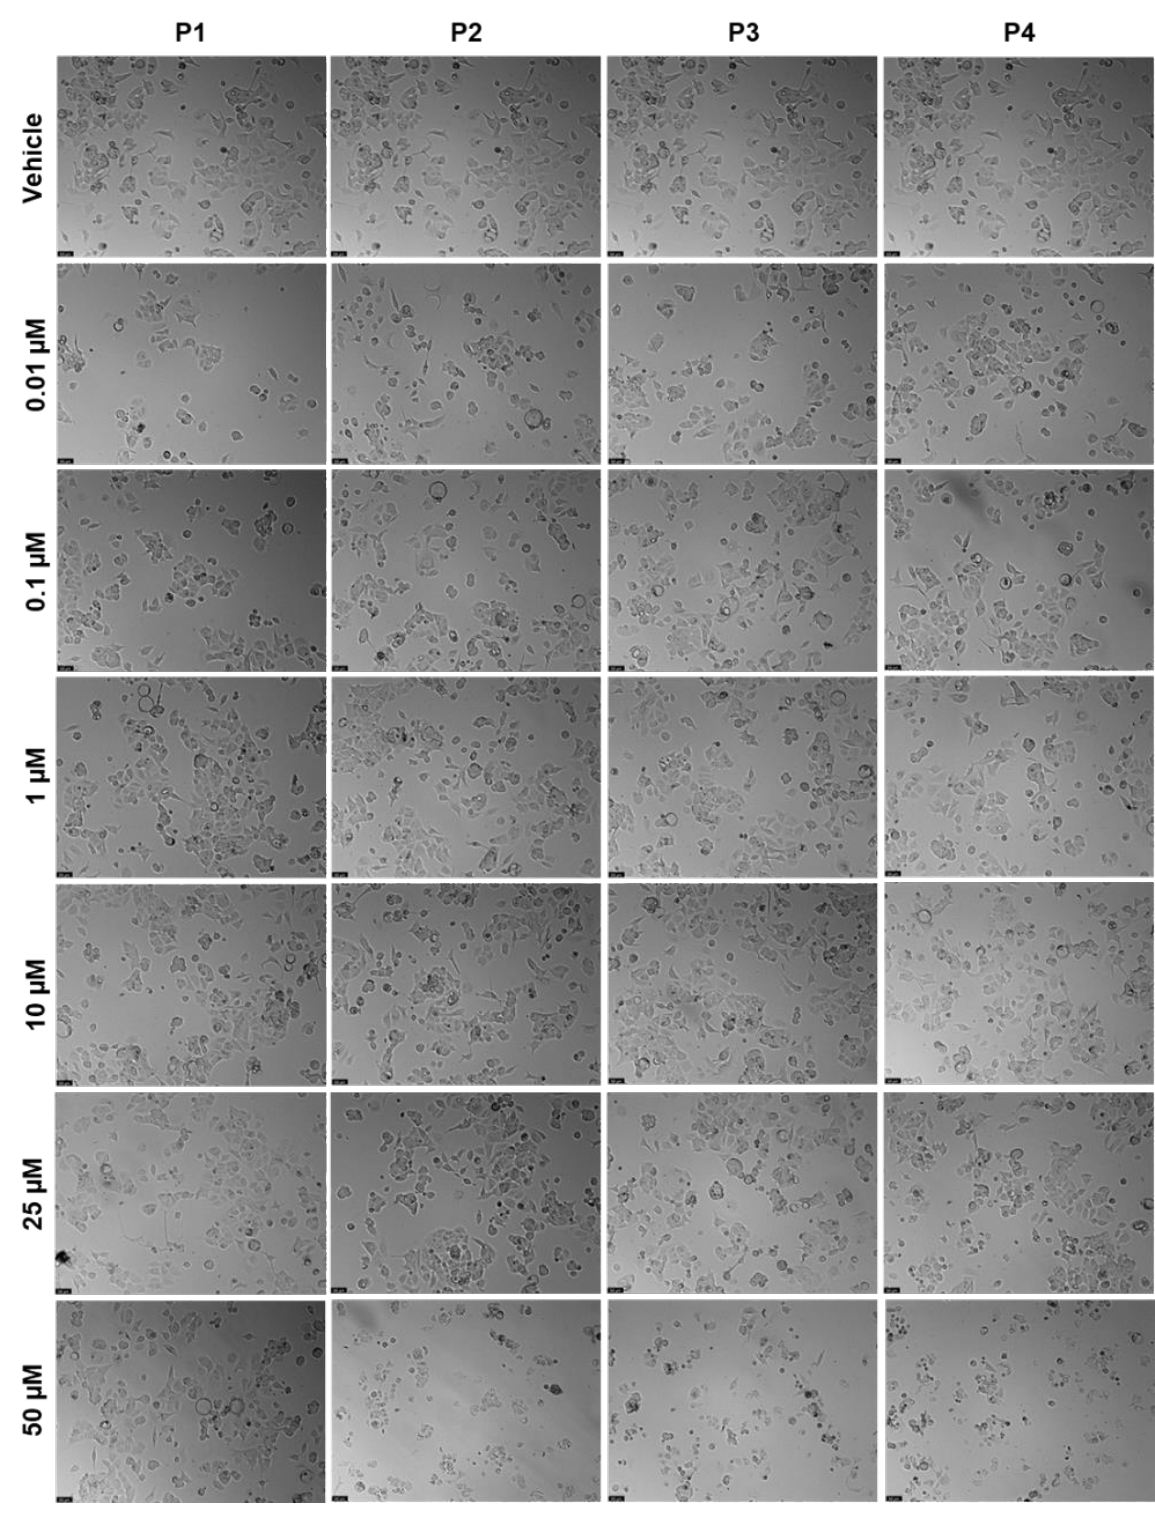
Figure 10. Morphological evaluation of MCF-7 after exposure to increasing concentrations of P1 – P4 (0.01 – 100 μM ) for 48 h. Control cells were treated with the vehicle (0.01% DMSO). These images are representative of three independent experiments. Scale bar is 200 μM.